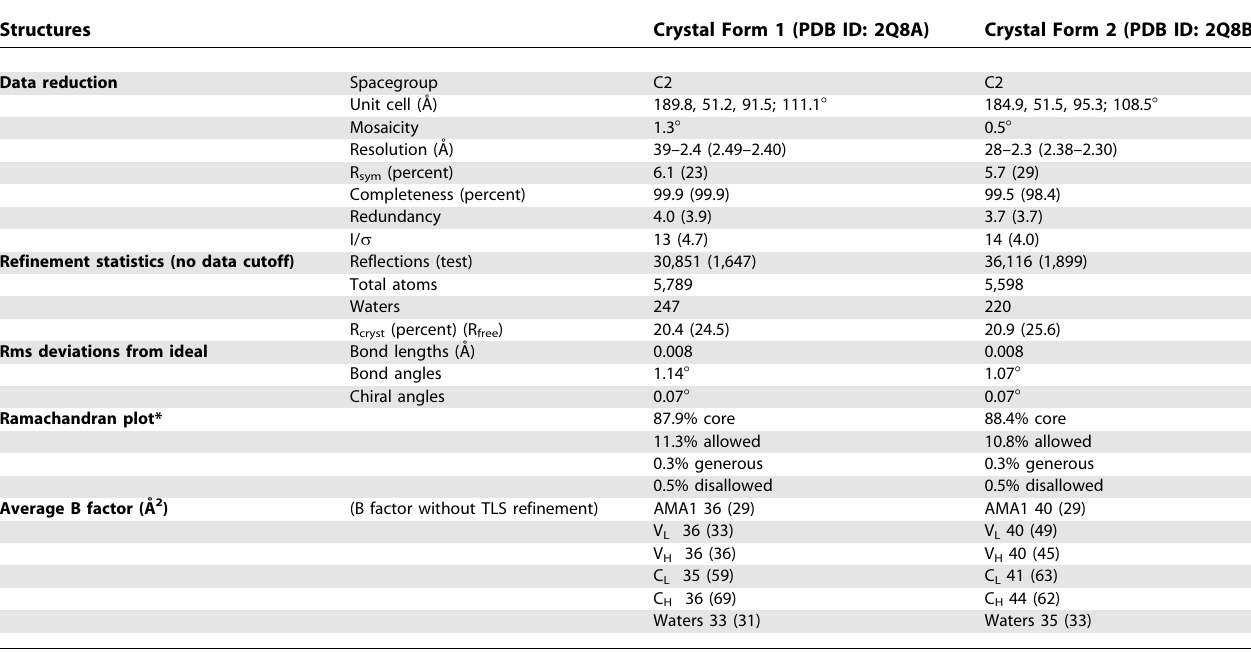
Table 1. Crystallographic Data and Refinement Statistics